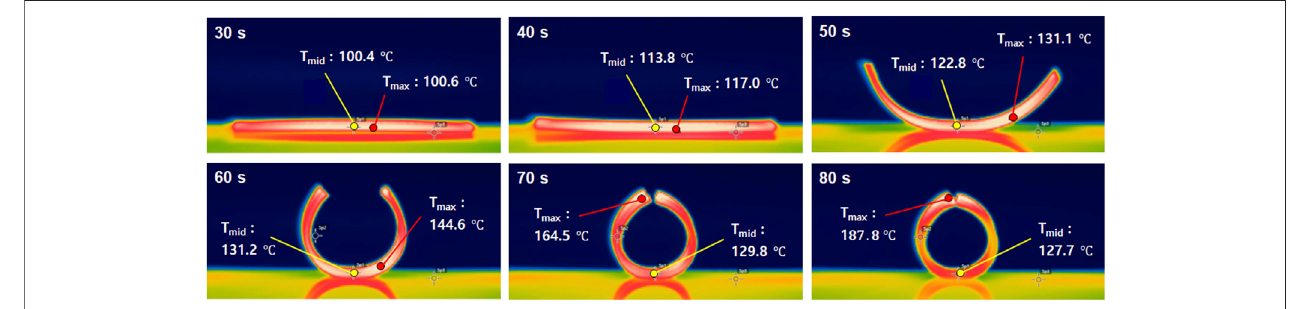
FIGURE3| GlobalshapetransformationsofabilayerbarwithincreasingIRirradiationtime.Here,T mid andT max indicatethetemperaturesatthemidpointandatthe maximum temperature point, respectively.